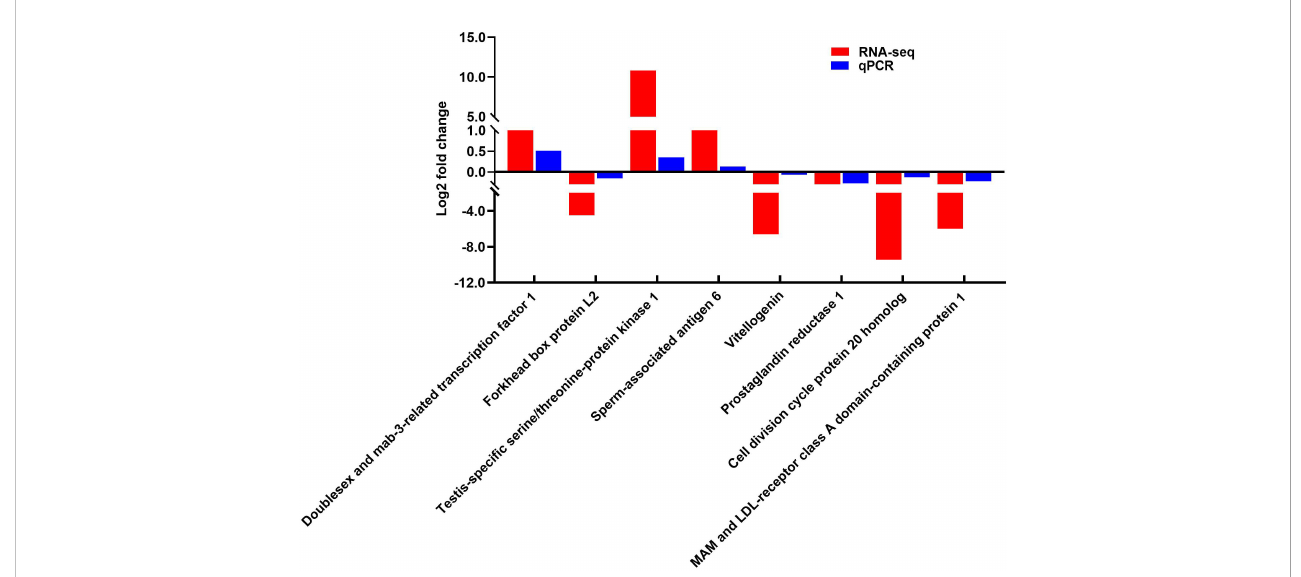
FIGURE 6 Expression levels of eight selected DEGs normalized to b -actin of C. sinensis was determined by qPCR.